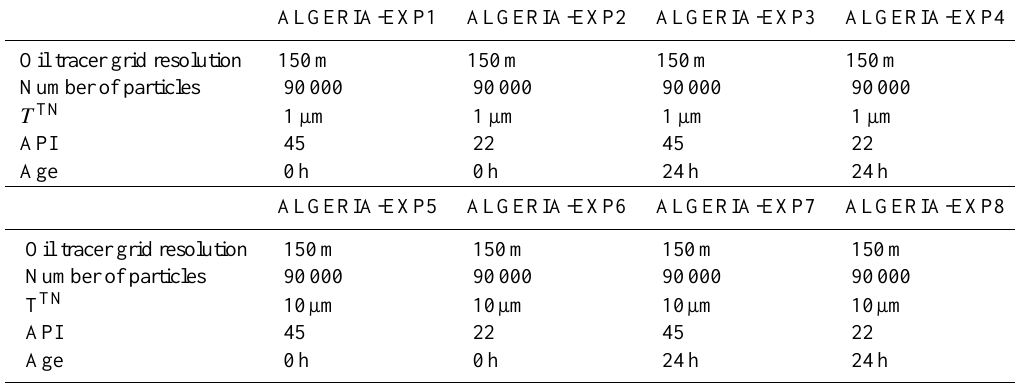
Table 5. Table of the experiments designed to study the model’s sensitivity to oil type, slick thickness and slick age.